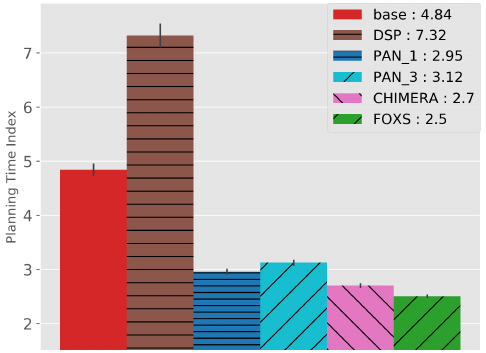
Figure 17. Traffic Efficiency Results—Cologne Scenario.